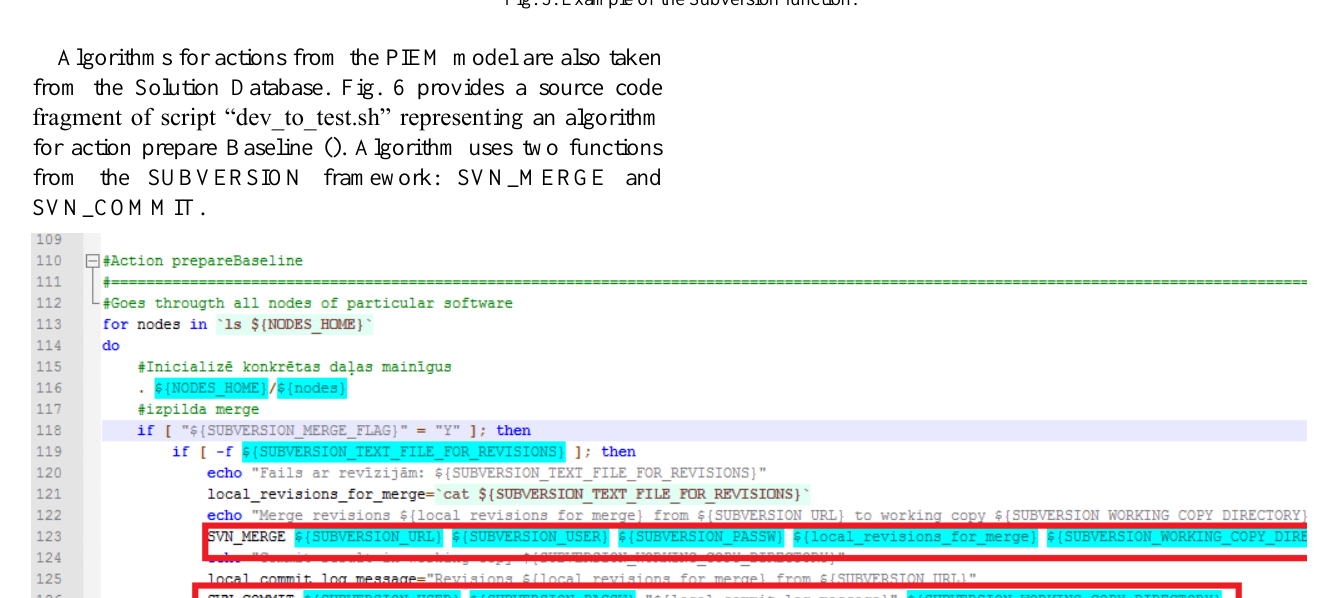
Fig. 5. Example of the Subversion function.